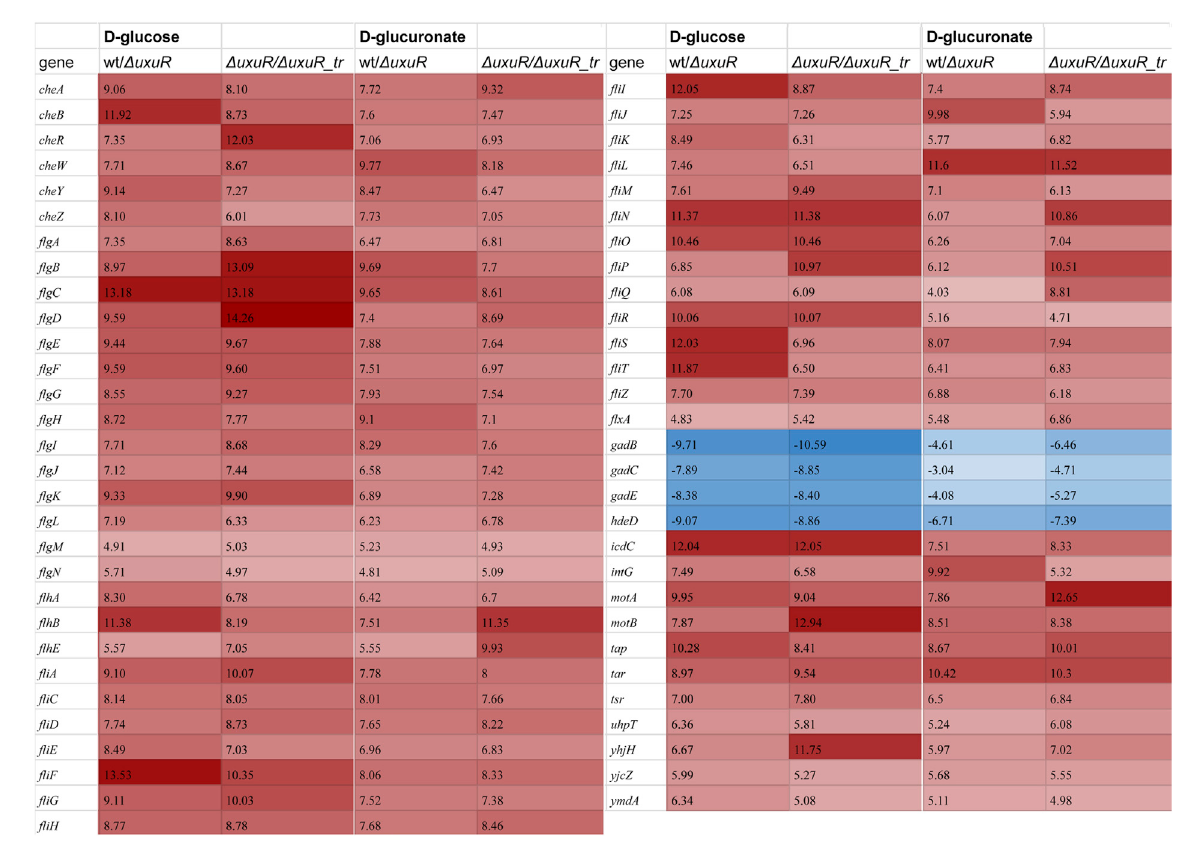
FIGURE 3 HeatmapdemonstratingdifferentialexpressionanalysisforthewildtypeK-12MG1655(wt),itswhole uxuR deletionderivative( Δ uxuR), andderivative with partial uxuR deletion only to switch protein synthesis off ( Δ uxuR_tr ). Values in the columns represent log 2 FC for the genes with signi fi cantly altered expression ( p -value < 0.001). A full list of genes which were affected ( p -value < 0.05) is shown in Supplementary Table S3. Red and blue colours indicate activation and repression, respectively. Growth conditions and compared strains are indicated in the column